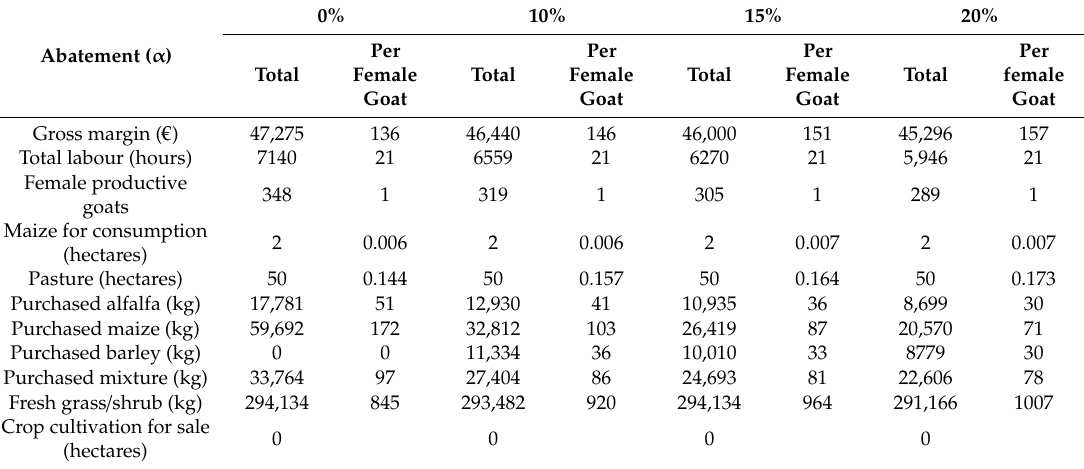
Table 10. Optimal farm plan of the semi-intensive